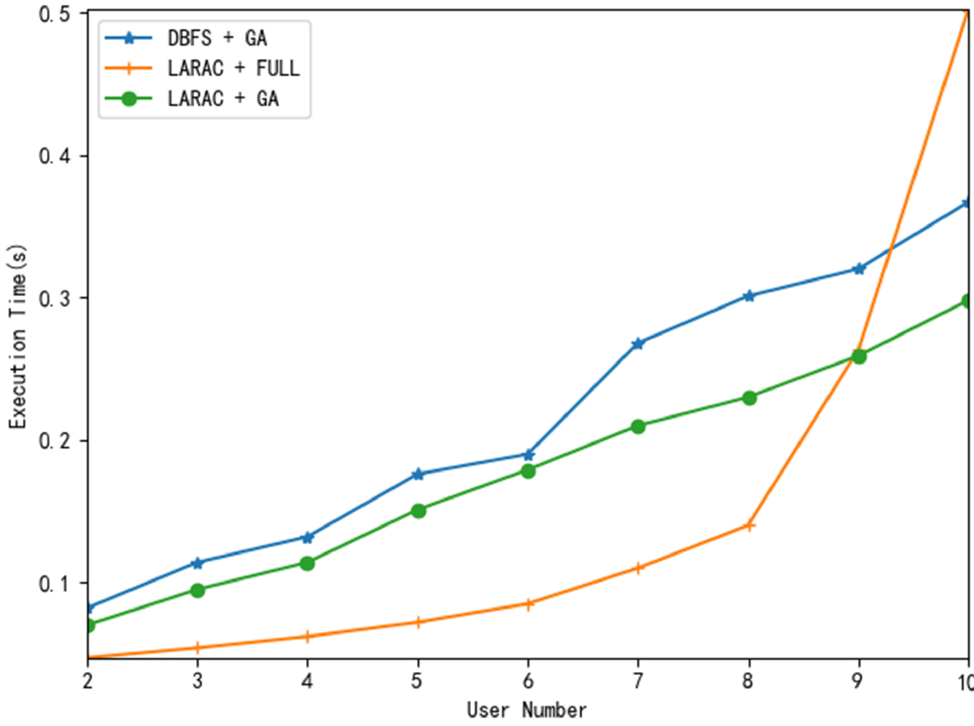
Figure 3. User number vs. execution time. LARAC, Lagrange relaxation-based aggregated cost. DBFS, Delay-constrained